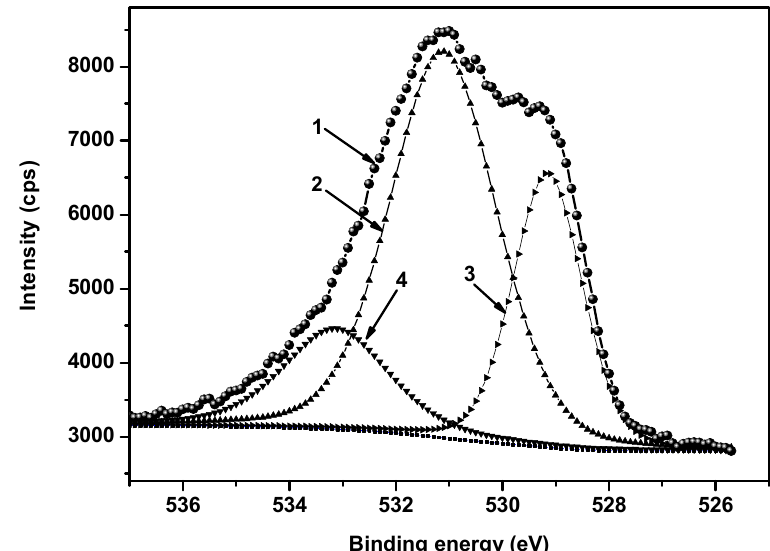
Figure 8. The phase composition (by XPS analysis) of oxide pellicles on samples of steel 45 (spectrum of oxygen on the surface) [12]: 1 – total spectrum; 2 – ОН - component; 3 – О 2- component; 4 – components of О - С and О - С = О